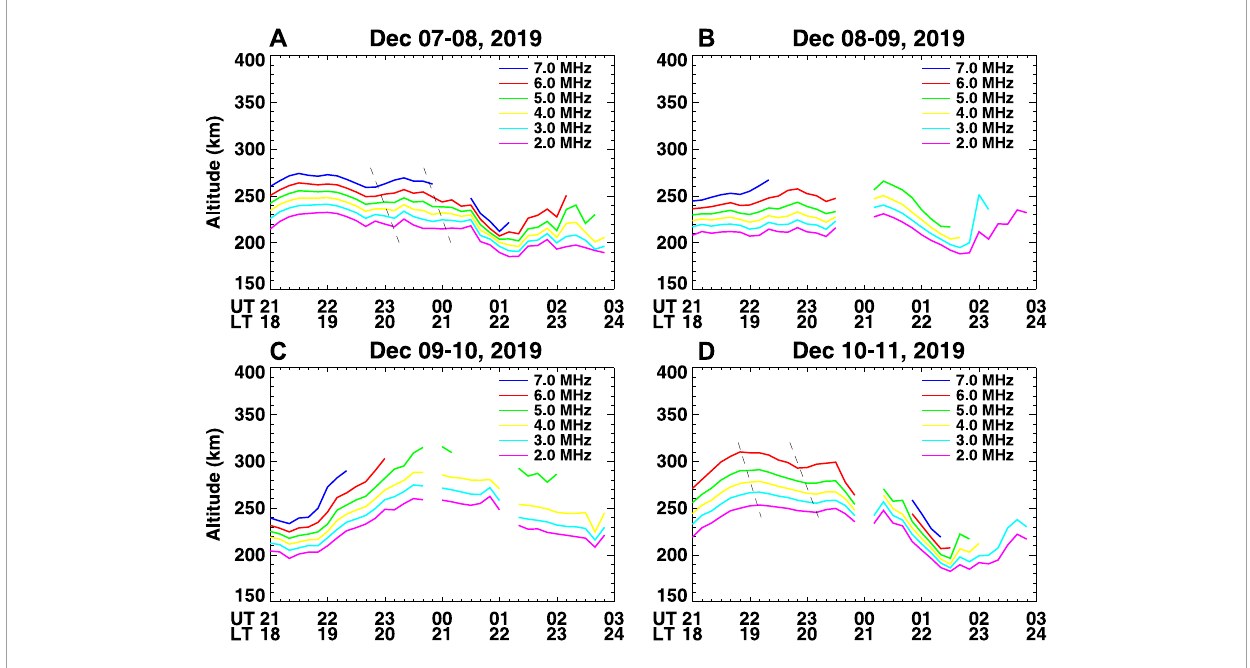
FIGURE 6 (A–D) Temporal variation of F-layer true heights for different frequencies between 2 and 7 MHz at Fortaleza station during 07–11 December 2019,